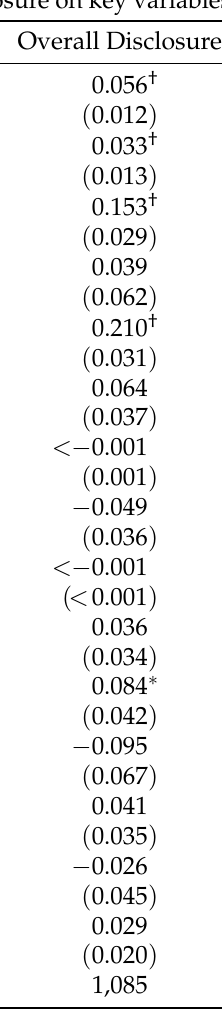
Table 5: Average marginal effects from binary logistic regression of sexual identity disclosure on key